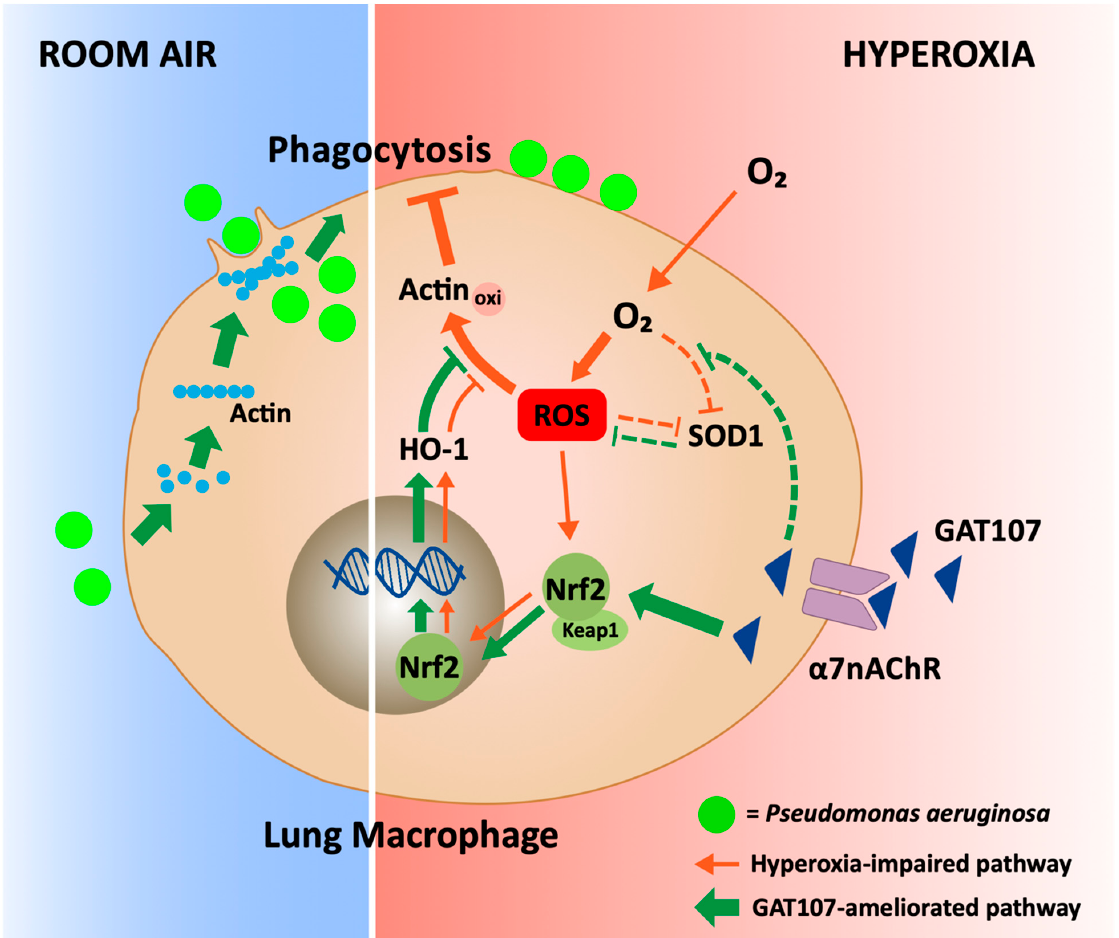
Figure 6. The proposed mechanism by which GAT107 restores bacterial clearance in the lungs by reducing oxidative stress, due to hyperoxia. Under room air conditions, Pseudomonas aeruginosa (PA) infection facilitates the re-organization of the F-actin cytoskeleton, thereby facilitating bacterial clearance by macrophage phagocytosis. The exposure of macrophages to hyperoxia increases ROS levels, which overwhelms the antioxidant response, resulting in oxidative stress (Morrow et al., 2007; Patel et al., 2016). Oxidative stress oxidizes actin, altering the formation of F-actin and impairing the phagocytic activity involved in bacterial clearance in the lungs. The α 7nAChR ago-PAM, GAT107, significantly restores hyperoxia- compromised phagocytic activity by inhibiting the oxidation of actin by attenuating the hyperoxia-induced decrease in SOD1 activity and the upregulating HO-1 via the Keap1/Nrf2 antioxidative pathway. These GAT107-mediated effects reverse the hyperoxia-induced impairment of macrophage phagocytosis.